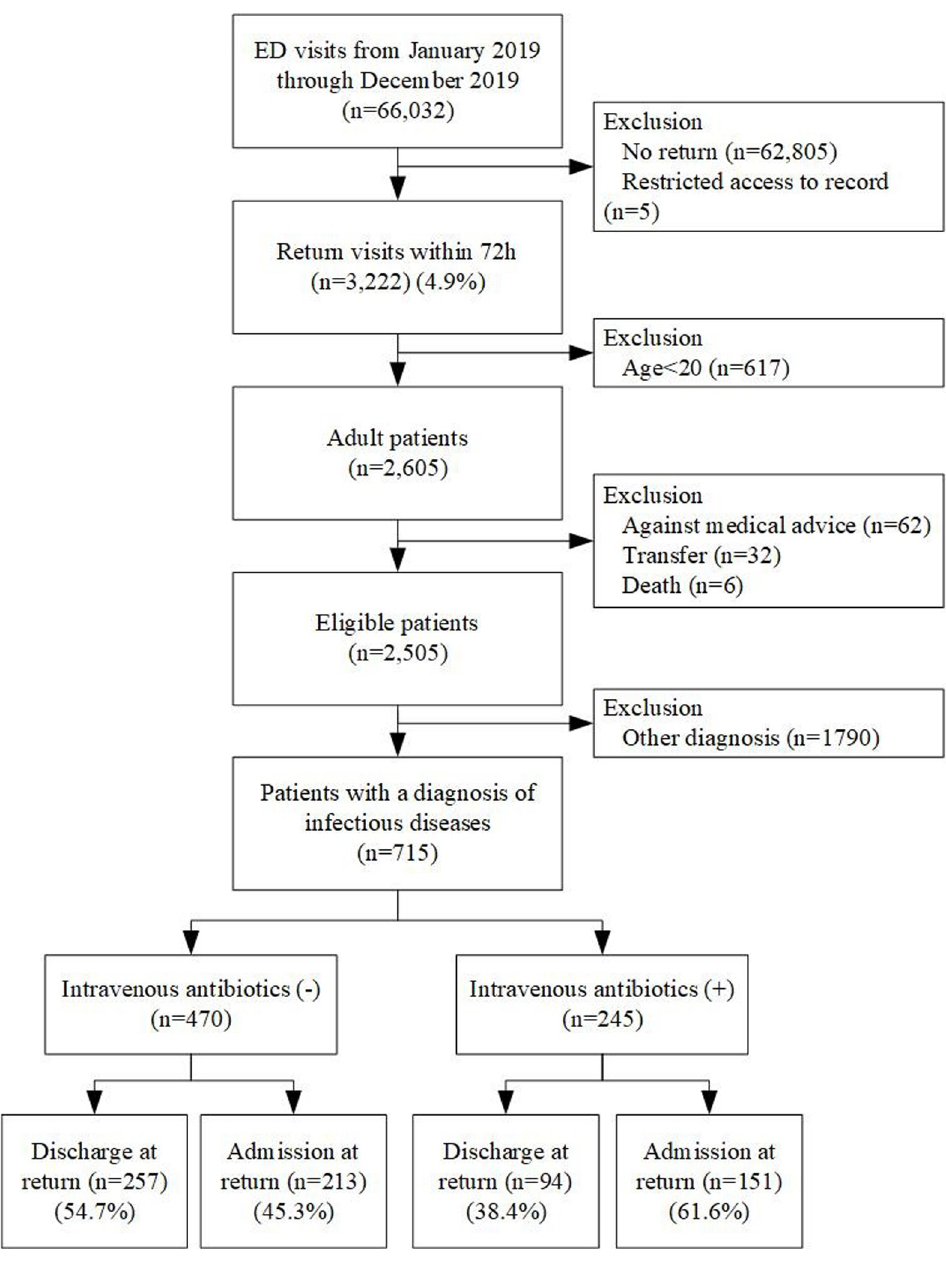
Fig 1. Study flow and patient